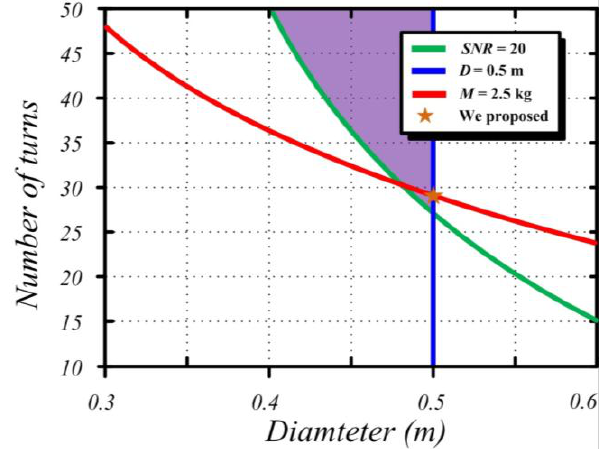
Figure 6. Contour maps of air-core coil mass M , size, and SNR